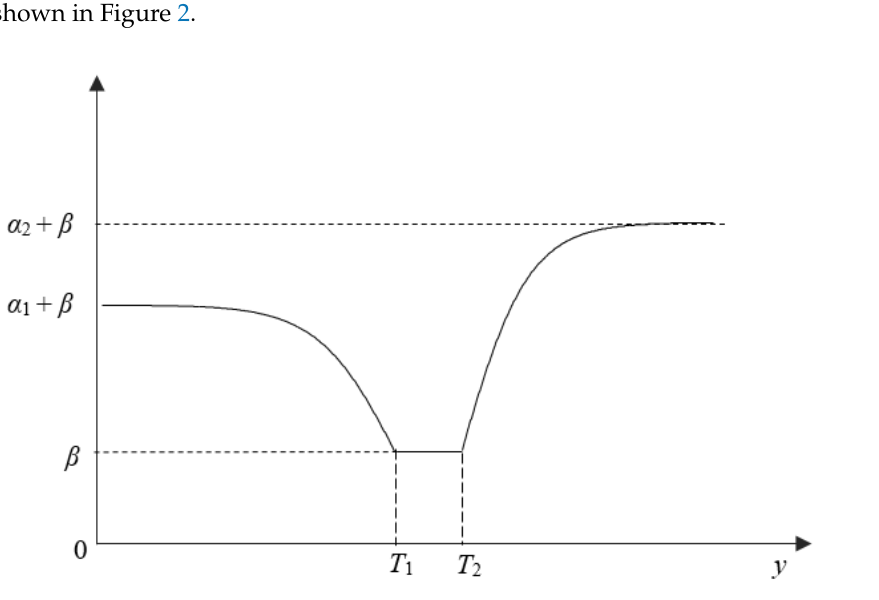
Figure 2. Asymmetric-hyperbolic tangent quality compensation function curve ( β > 0).